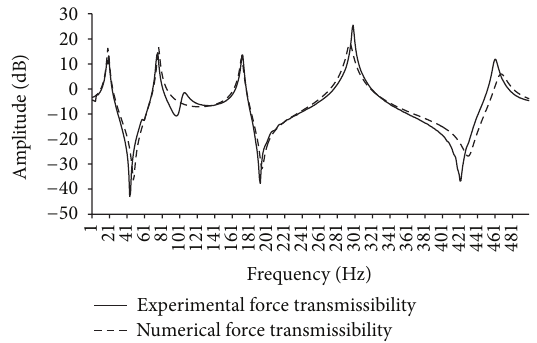
Figure 8: Experimental and numerical force transmissibility 𝑇 1,7 .